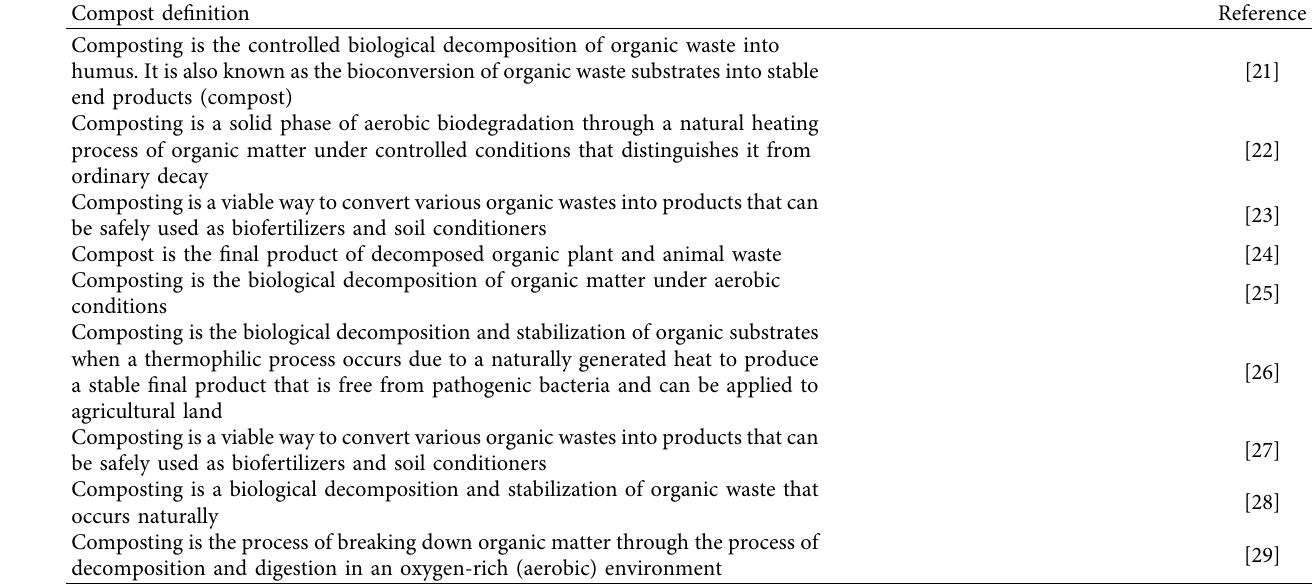
Figure 1: Procedure, criteria, inclusion, and exclusion for systematic review studies. Table 1: Defnitions of composting obtained from several